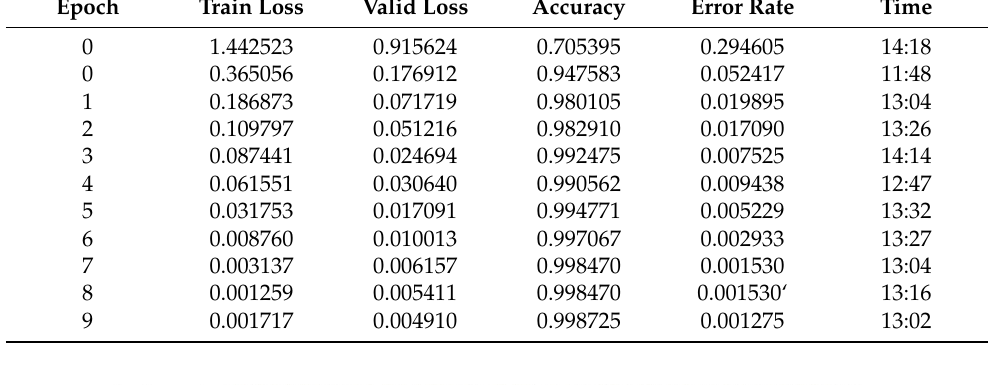
Table 13. Results of the AlexNet.